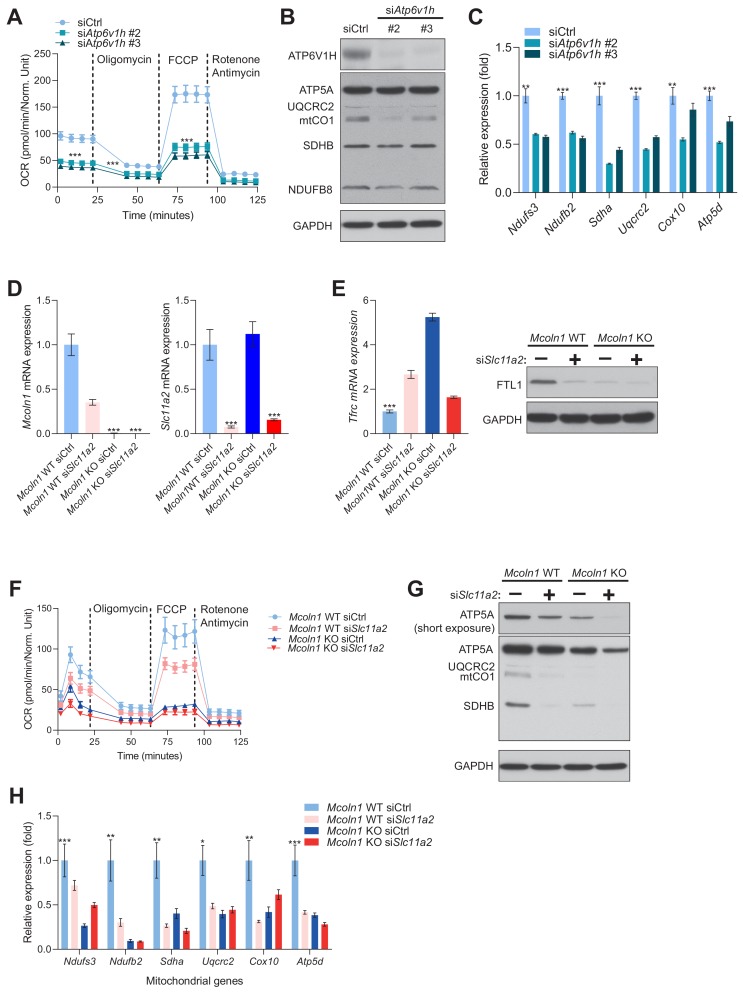
Impaired lysosomal iron efflux results in decreased mitochondrial biogenesis and function.(A) Mitochondrial OCR in fibroblasts with siRNA mediated silencing of Atp6v1h. Results represent mean ± SEM, n = 3. Each experimental replicate is calculated from the average of 16 technical replicates. ***p<0.001, Welch’s one-way ANOVA with Dunnett’s correction for multiple comparisons. (B) Immunoblots of whole cell extracts showing ATP6V1H, ATP5A, UQCRC2, mtCO1, SDHB, and NDUFB8, Atp6v1h knockdown fibroblasts. GAPDH is used as loading control, n = 3 independent experiments. (C) Mitochondrial biogenesis is repressed in fibroblasts with Atp6v1h silencing as assessed by the expression of nuclear-encoded mitochondrial genes. Results are shown as bar graphs representing mean ± SEM of six independent experimental replicates. **p<0.01; ***p<0.001, Welch’s one-way ANOVA with Dunnett’s correction for multiple comparisons. Mean differences compared between siCtrl and the other experimental groups. (D) Expression levels of Mcoln1 (left) and Slc11a2 (right) in siRNA-mediated knockdown of Slc11a2 in Mcoln1-/- mouse embryonic fibroblast and their wild type control fibroblasts. Bars represent mean ± SEM, n = 6 biological replicates. ***p<0.0001, unpaired two-tailed t-test with Welch’s correction. (E) Tfrc mRNA levels in Mcoln1 WT and KO fibroblasts with siRNA-mediated silencing of Slc11a2 (left). Relative Tfrc expression is shown as bars representing mean ± SEM, n = 6 biological replicates. ***p<0.001, determined by the Welch’s one-way ANOVA followed by Dunnett’s correction for multiple comparisons of all groups to the Mcoln1 WT siCtrl group. Immunoblots of HIF-1α, FTH1, FTL1 with GAPDH as loading control in Mcoln1 WT and KO fibroblasts with siRNA-mediated silencing of Slc11a2 are also shown for n = 3 biological samples (right). (F) Mitochondrial OCR in Mcoln1 WT and KO fibroblasts with Slc11a2 knockdown. Results represent mean ± SEM, n = 3. Each experimental replicate is calculated from the average of 9 technical replicates. ***p<0.001, Welch’s one-way ANOVA with Dunnett’s correction for multiple comparisons (G) Immunoblots of ATP5A, UQCRC2, mtCO1 AND SDHB in lysates prepared from Mcoln1 WT and KO fibroblasts with siRNA-mediated knockdown of Slc11a2. GAPDH is used as loading, n = 3 independent experiments. (H) Reduced levels of nuclear-encoded mitochondrial transcripts in either Mcoln1 KO fibroblasts, Slc11a2 knockdown fibroblasts or both. Results are shown as bar graphs representing mean ± SEM of six independent experimental replicates. *p<0.05; **p<0.01; ***p<0.001, determined by the Welch’s one-way ANOVA followed by Dunnett’s correction for multiple comparisons of all groups to the Mcoln1 WT siCtrl group.